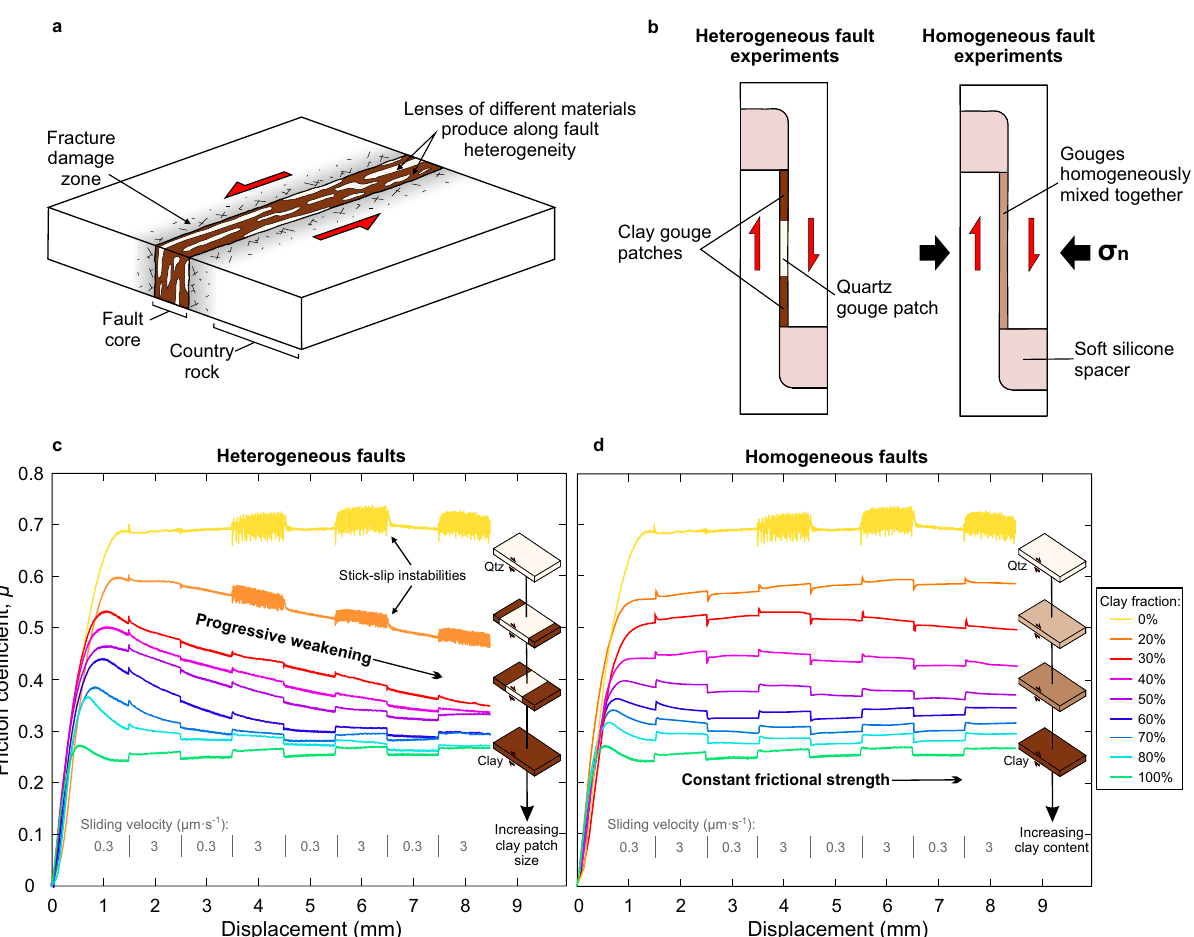
Fig. 1 Mechanical behaviour of laterally heterogeneous vs. homogeneously mixed clay-quartz fault gouge layers. a Schematic diagram of a typical natural fault zone showing how lenses of different materials trapped within the fault core produces a heterogeneous structure. b Simpli fi ed diagrams of the experimental setup for the heterogeneous fault experiments, where quartz and clay gouges are separated into adjacent patches, and homogeneous fault experiments where the two gouges are homogeneously mixed together. c Evolution of the friction coef fi cient ( µ ) with displacement for the heterogeneous experimental faults and, ( d ) the homogeneous experimental faults. Heterogeneous faults show ubiquitous post-yield weakening with increasing displacement, in contrast to homogeneous faults where µ remains relatively constant once the layer has yielded after approximately 1 mm of slip. For pure quartz and heterogeneous faults where the quartz patch comprises ≥ 80% of the total fault area, stick-slip instabilities occur, triggered by up-steps in the sliding